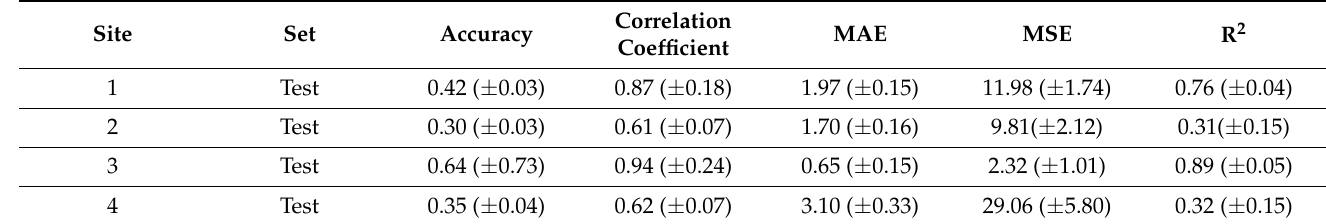
Table 13. Correlations obtained for fully developed DTs with depth.